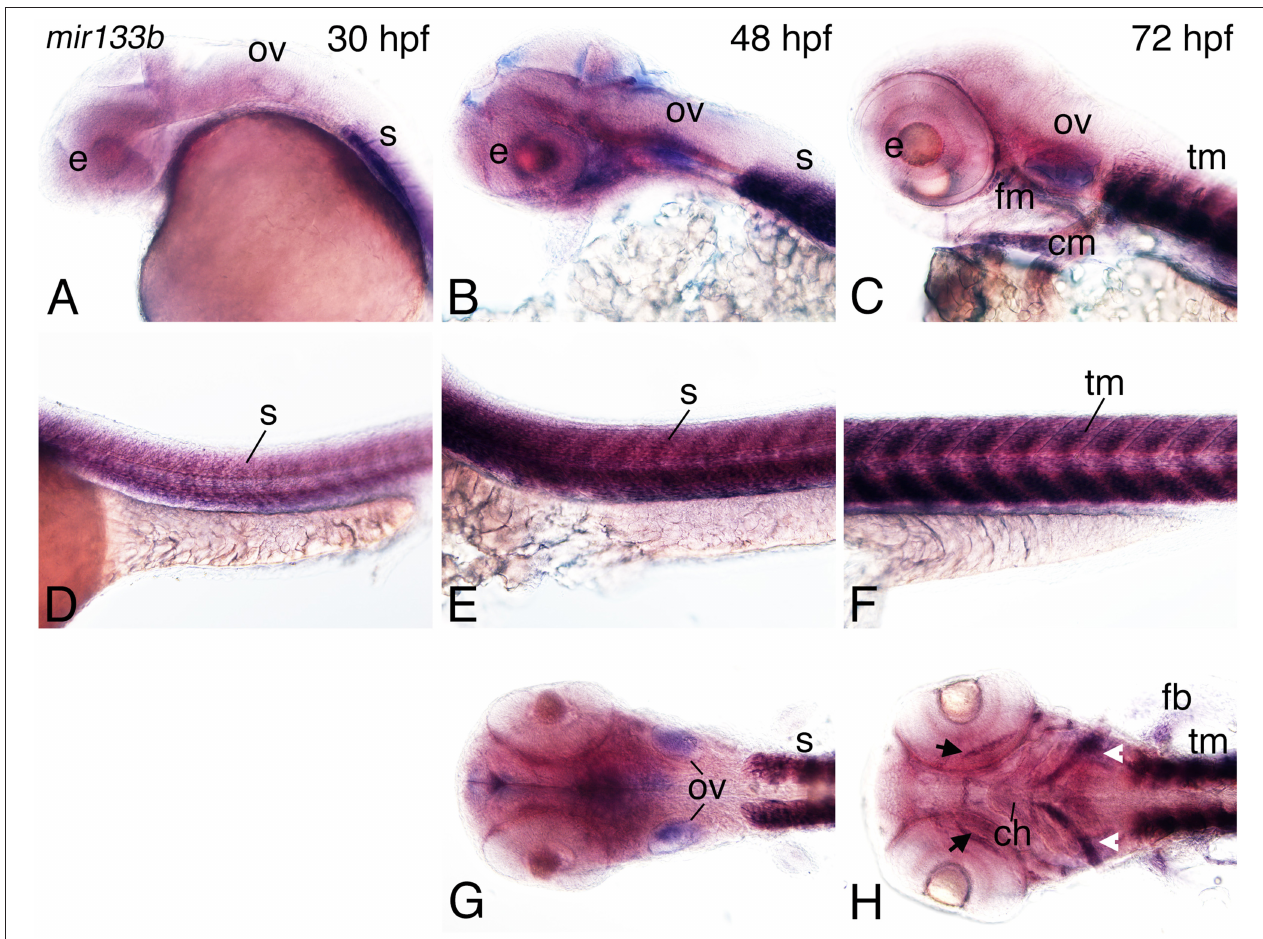
FIGURE 6 | Expression of mir133b in zebrafish embryos. Whole-mount in situ hybridization analysis with a digoxigenin-labeled probe against mir133b at 30–72hpf. (A–C) Expression is observed in the developing pharyngeal region, including at 48hpf in the facial muscle (fm) and otic vessicle (B,G) . (D–F) Strong expression of miR133b is observed in the somites (s; D ) at 30hpf, somites (E), and pectoral fin (pf) at 48hpf (H) and facial muscle (fm; C ), cardiac muscle (cm; C ), and trunk muscle (tm; F ) at 72hpf, including the anterior mandibularis (arrows) and stemohyoideus (arrowheads) facial muscles muscles. Anterior is to the left. e, eye; tm, trunk muscle; n, notochord; ch,